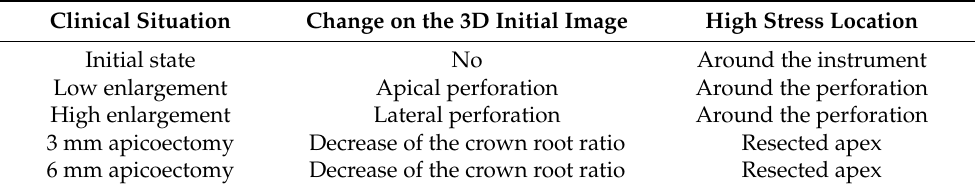
Table 3. Patient-specific analysis based on the 3D image and maximal Von Mises stress of the different removal